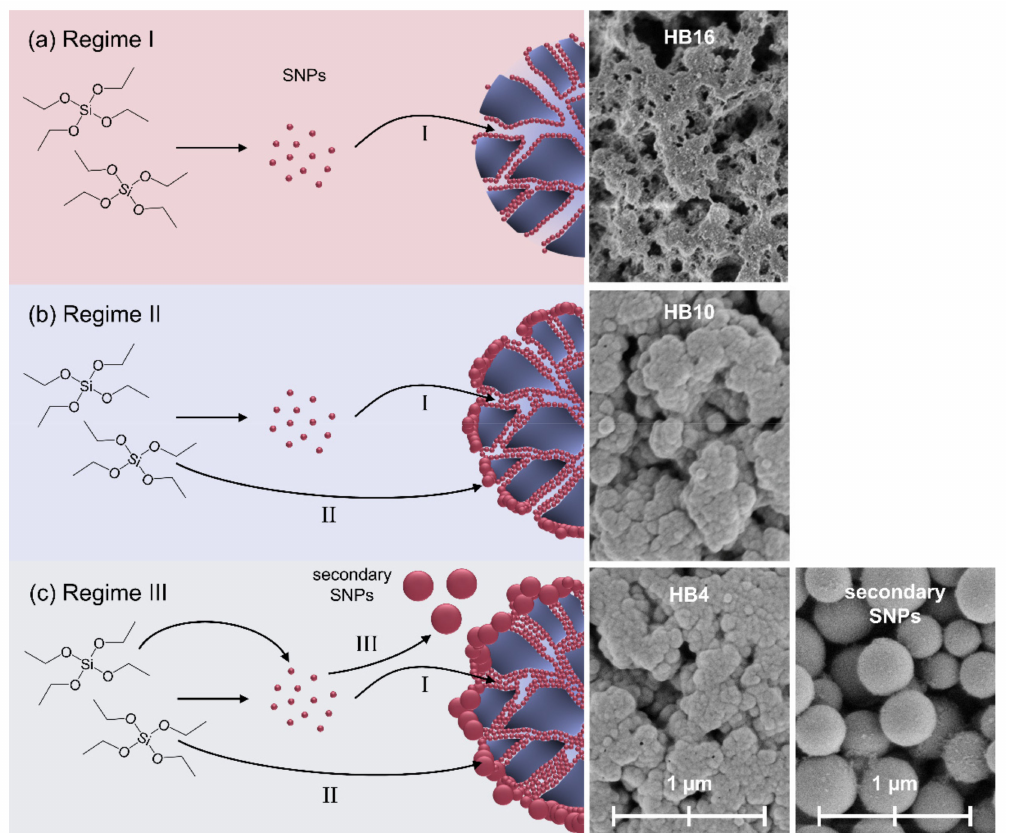
Figure 7. ( a ) Regime I corresponds to relatively low water values, ( b ) Regime II corresponds to medium values and ( c ) Regime III corresponds to high water-to-precursor ratios. Exemplarily, the regions are derived from the particles HB16, HB10 and HB4, respectively. It shows the diffusion of SNPs, after exceeding the supersaturation concentration, into the template. There, they aggregate in the absence of monomer (I). The hydrolysis is accelerated (Regime II), which deposits in the pores (I) and on the HB surface, where they undergo both the aggregation of SNPs and monomer addition, as they are in contact with the reaction medium (II). In Regime III, with highest hydrolysis/condensation rate, SNPs additionally undergo monomer addition (III) in the continuous phase, forming secondary particles, which are not attached to the